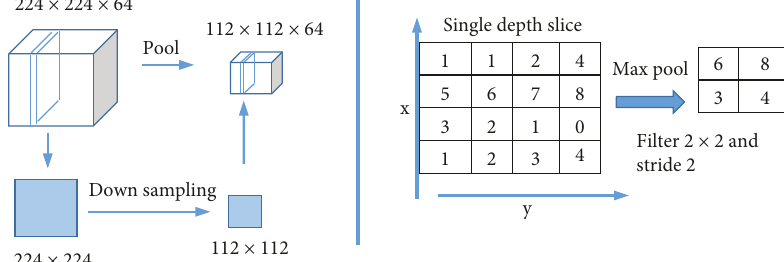
Figure 8: Illustrating the operation of the pooling layer [29, 30].